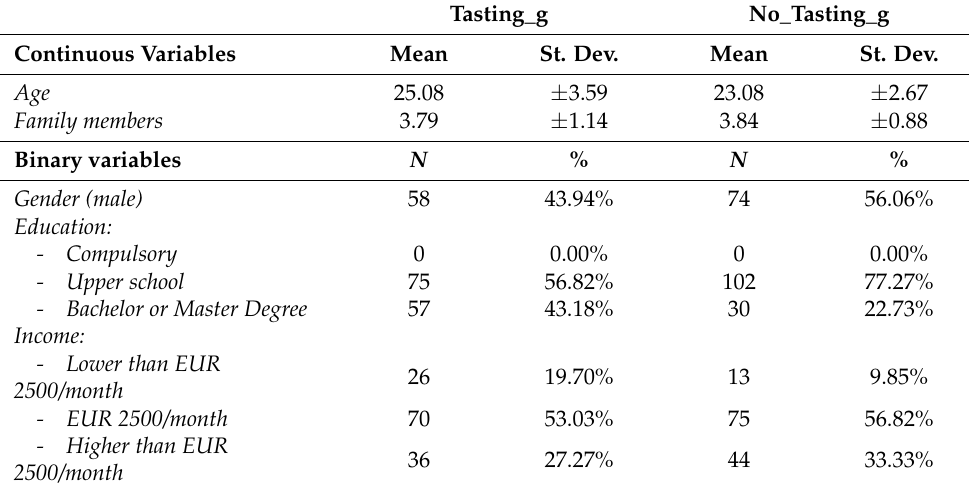
Table 3. Descriptive statistics of the two groups (Tasting_g and No_Tasting_g).